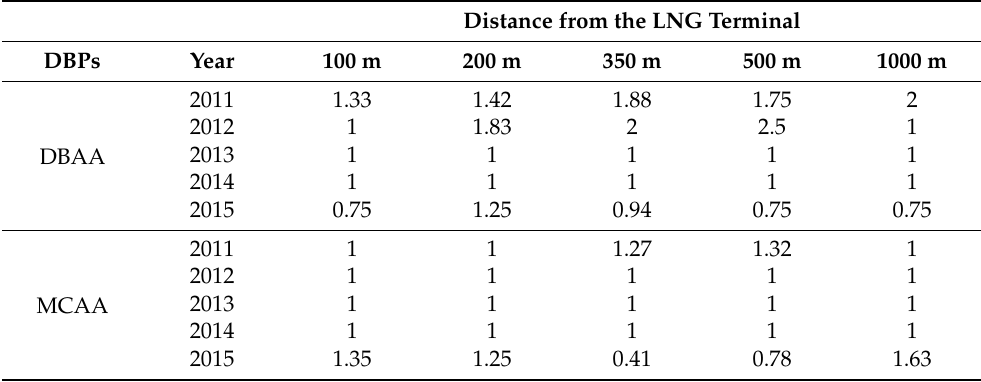
Table 2. Sediment concentration ratios (SCRs) for DBAA and MCAA resulted during monitoring activities of an LNG terminal in the Northern Adriatic Sea. (1) July, (2) September. Distance from the LNG Terminal